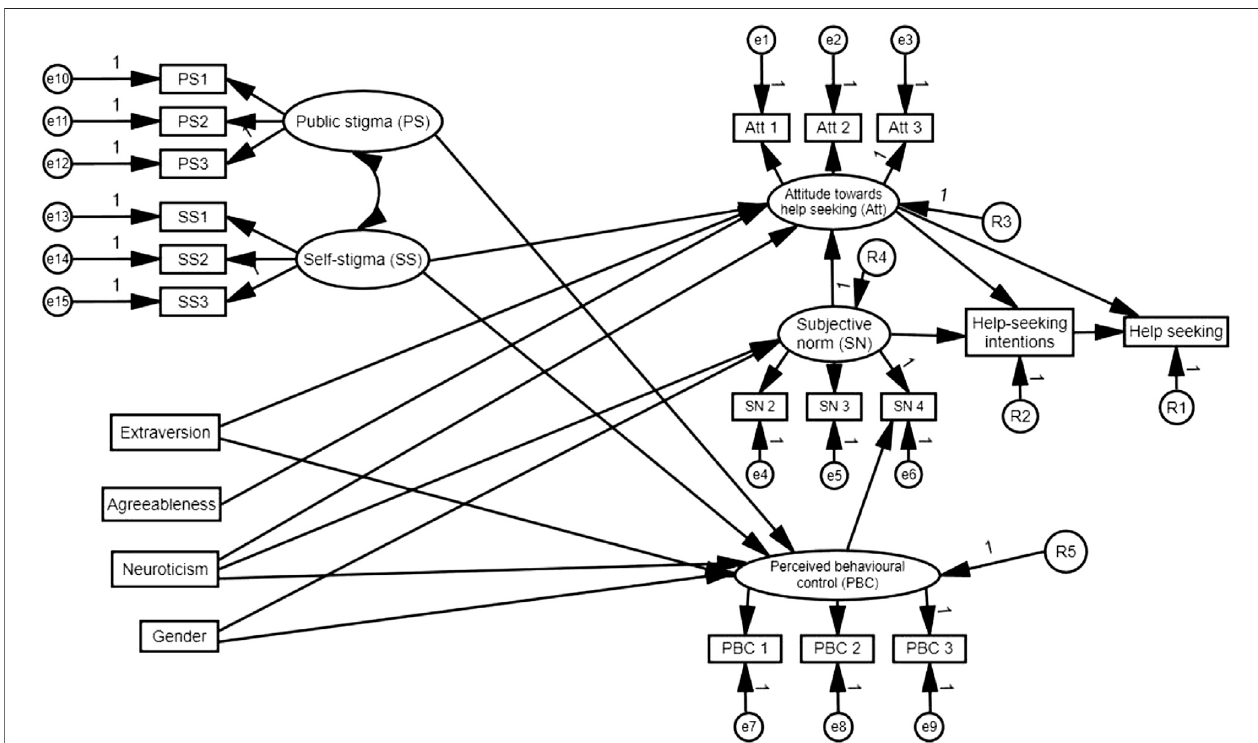
FIGURE 4 | Final model with good fi